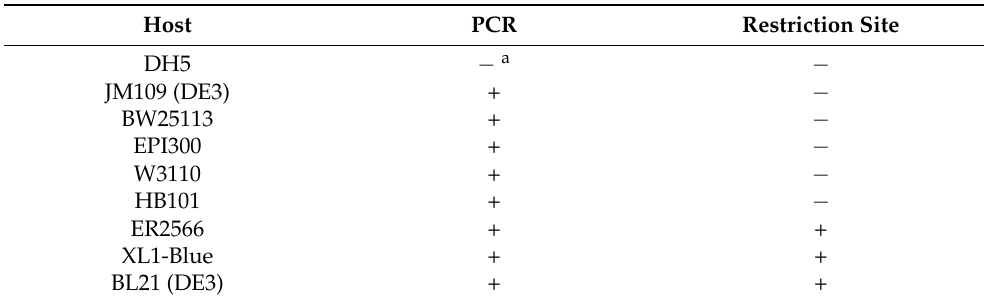
Table 2. Verification of the target gene 8 msh using PCR amplification and restriction site cutting.